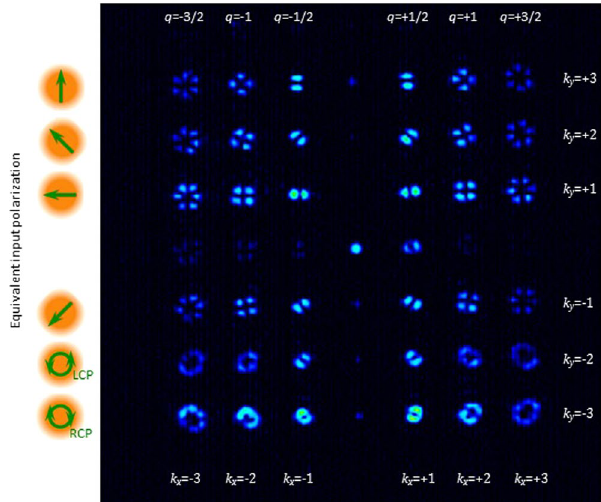
Figure 4. Experimental single-shot generation of 6 × 6 vector beams. Horizontal orders encode q -plates with different q -values, while vertical orders have different states of